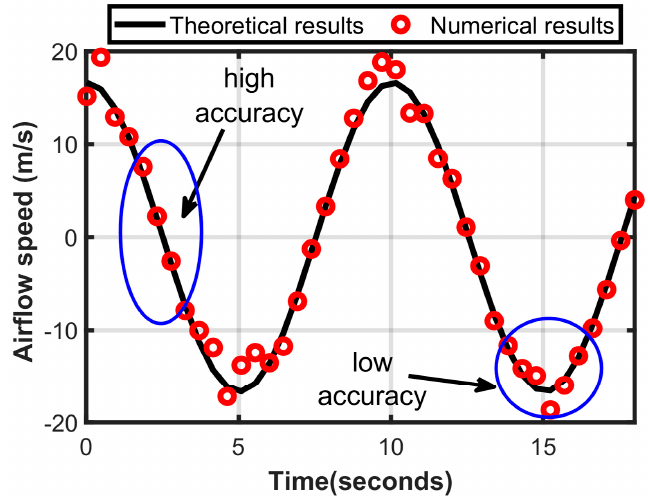
Figure 5. Airflow speed